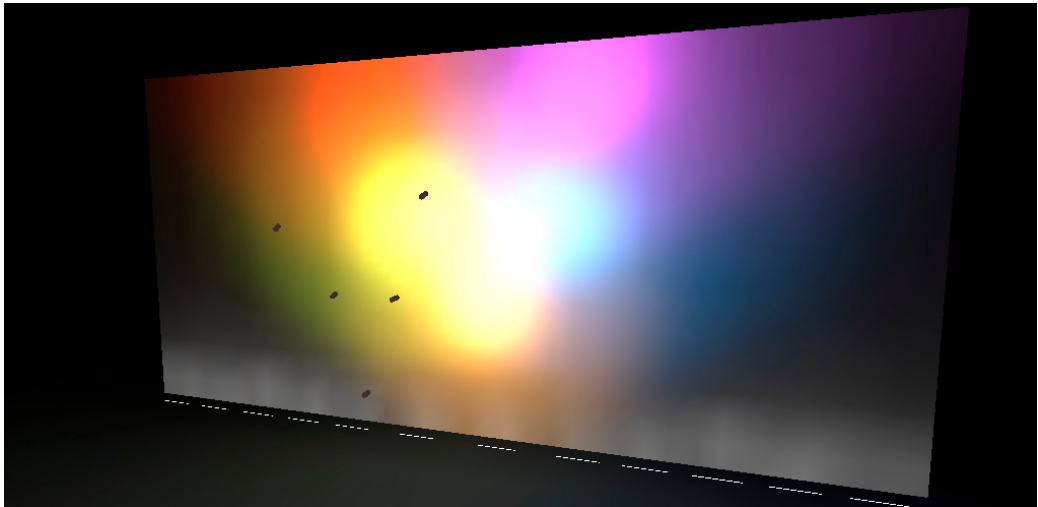
Figure 15. Simulation of visual result of Working Diagram II—Scene 2: orientation and color of lighting sources are modified.